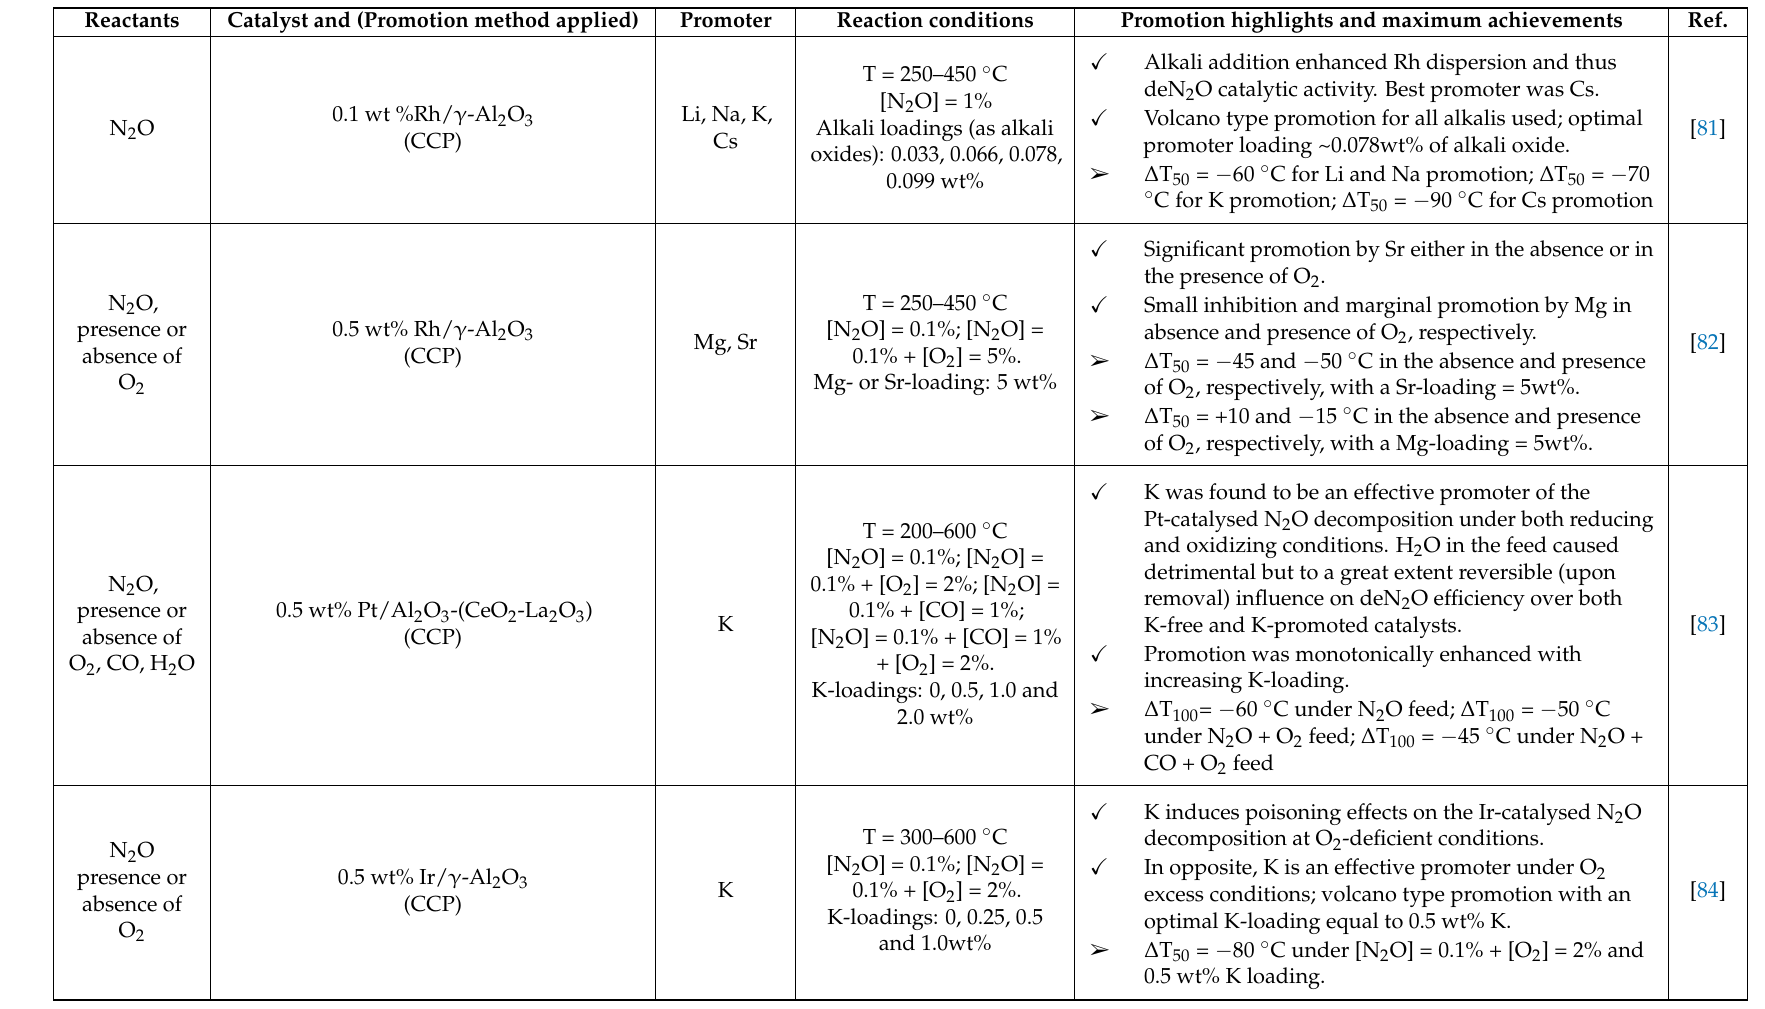
Table 5. Electropositive promotion of PGMs-catalysed N 2 O decomposition and/or reduction